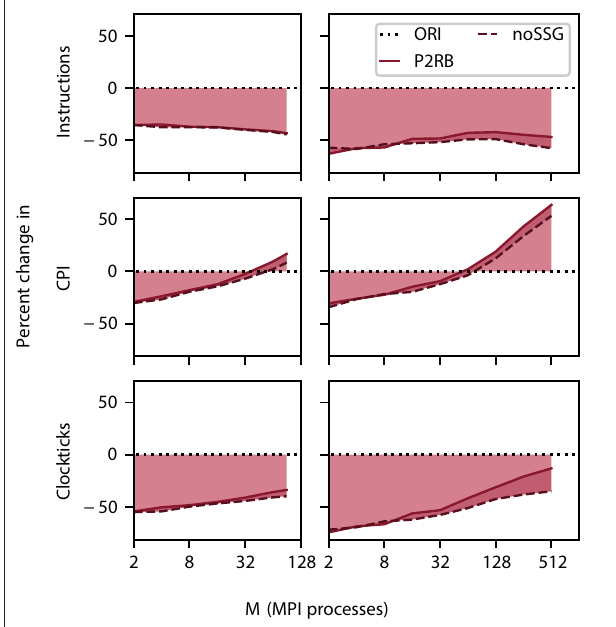
FIGURE 5 | Relative change in instructions retired (top row), clockticks per instruction retired (CPI, middle), and clockticks (bottom) during spike delivery for P2RB (including SRR as in Figure 4 ), and noSSG as a function of the number of MPI processes. Raw data for all three quantities was obtained by VTune (Section 3.4.1). Left column DEEP-EST CM and right column JURECA CM: linear-log representation for number of MPI